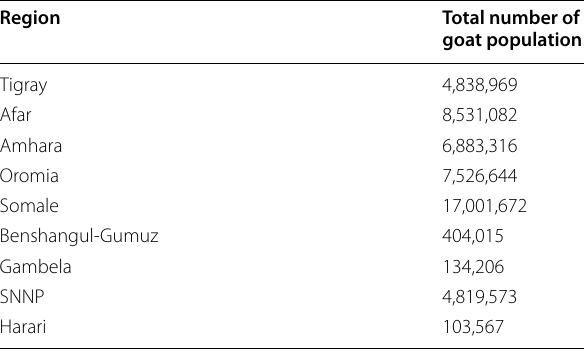
Table 2 The numbers and regional distribution of indigenous Ethiopian goat breeds. Source : CSA (2020)